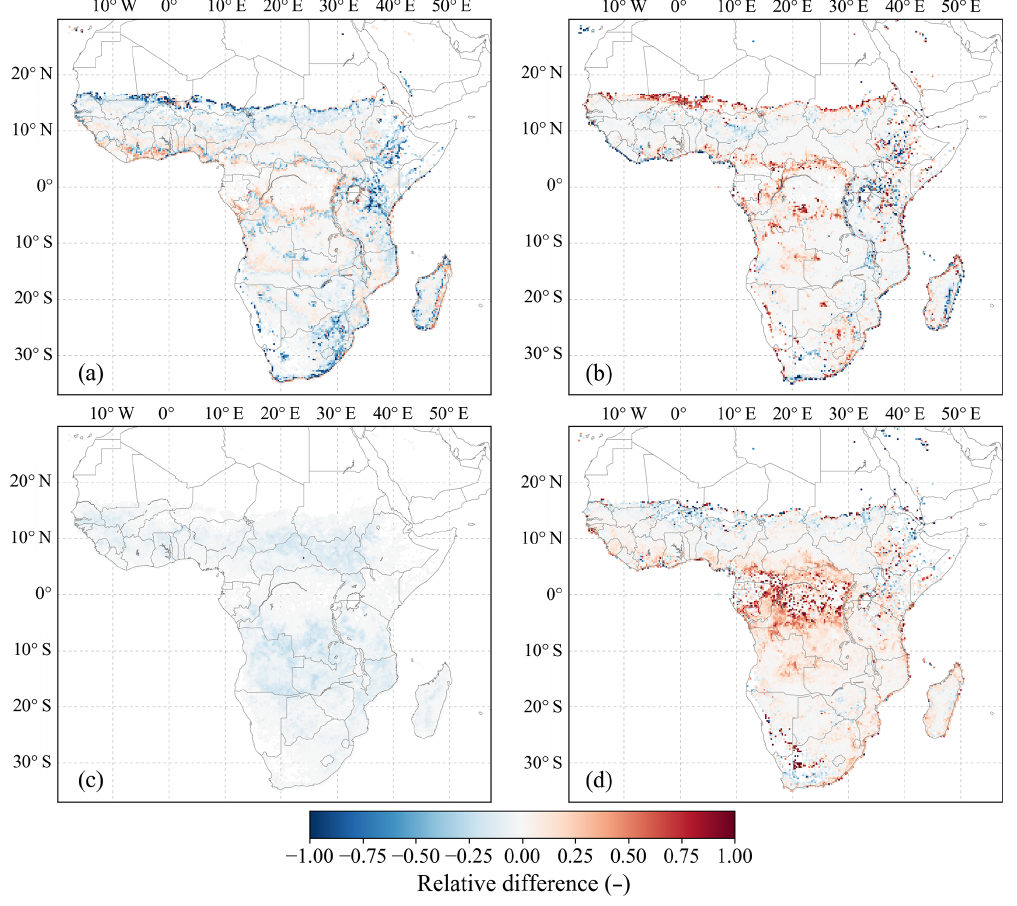
Figure 9. Relative simulation differences in fire emissions (and FC) for various isolated mechanisms, as the natural logarithm of the 0.25 ◦ model result over the 500m model result. Panel (a) shows the isolated difference due to the biome-specific parameter error, (b) the additional difference due to the input aggregation error, (c) the difference accounted for by implementation of the modified burned fraction (MBF), and (d) the remaining unexplained difference after subtraction of (a–c) . The 500m resolution model results are aggregated to 0.25 ◦